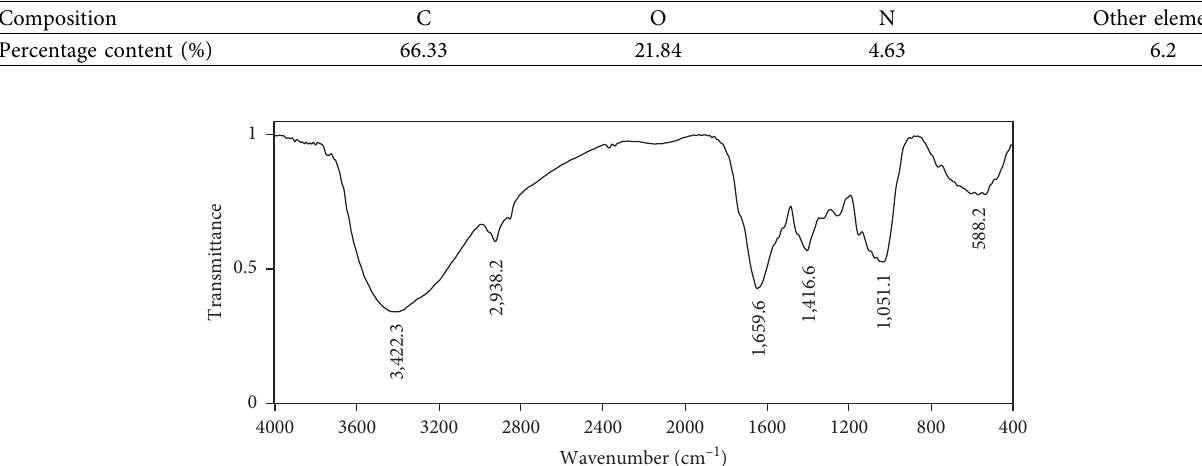
Figure 3: FTIR spectra of